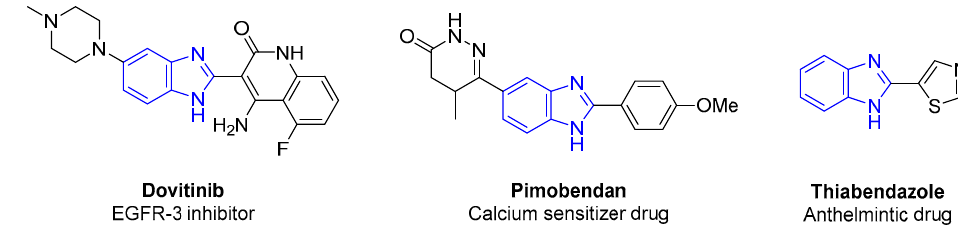
Figure 1. Benzimidazole derivatives with biological activity.